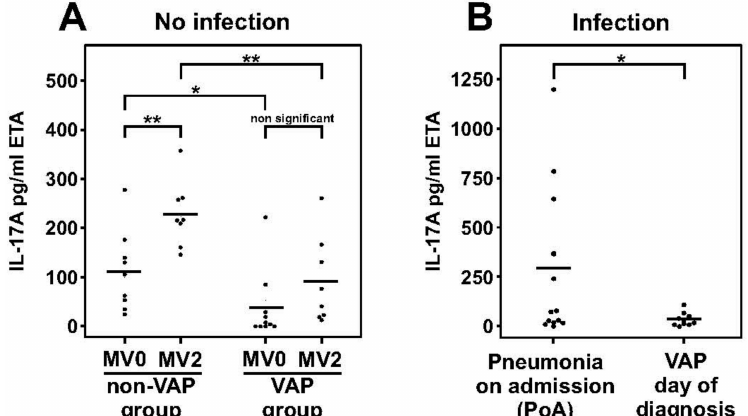
Figure 3. Dampened IL-17A response in ventilator-associated pneumonia (VAP) patients. ( A ) MV-induced IL-17 protein secretion in endotracheal aspirate (ETA) samples in patients who developed VAP (VAP group) and those that did not (non-VAP group) after 48 h (MV2) compared to the pre-MV timepoint (MV0). The VAP group had lower IL-17A levels than the non-VAP group at both the MV0 and MV2 timepoints. ( B ) Dampened IL-17A response was observed in VAP patients on the day of diagnosis compared to patients who arrived in the ICU with pneumonia (PoA). Line represents the average, dots are individual values of each patient; * p < 0.05, and ** p <